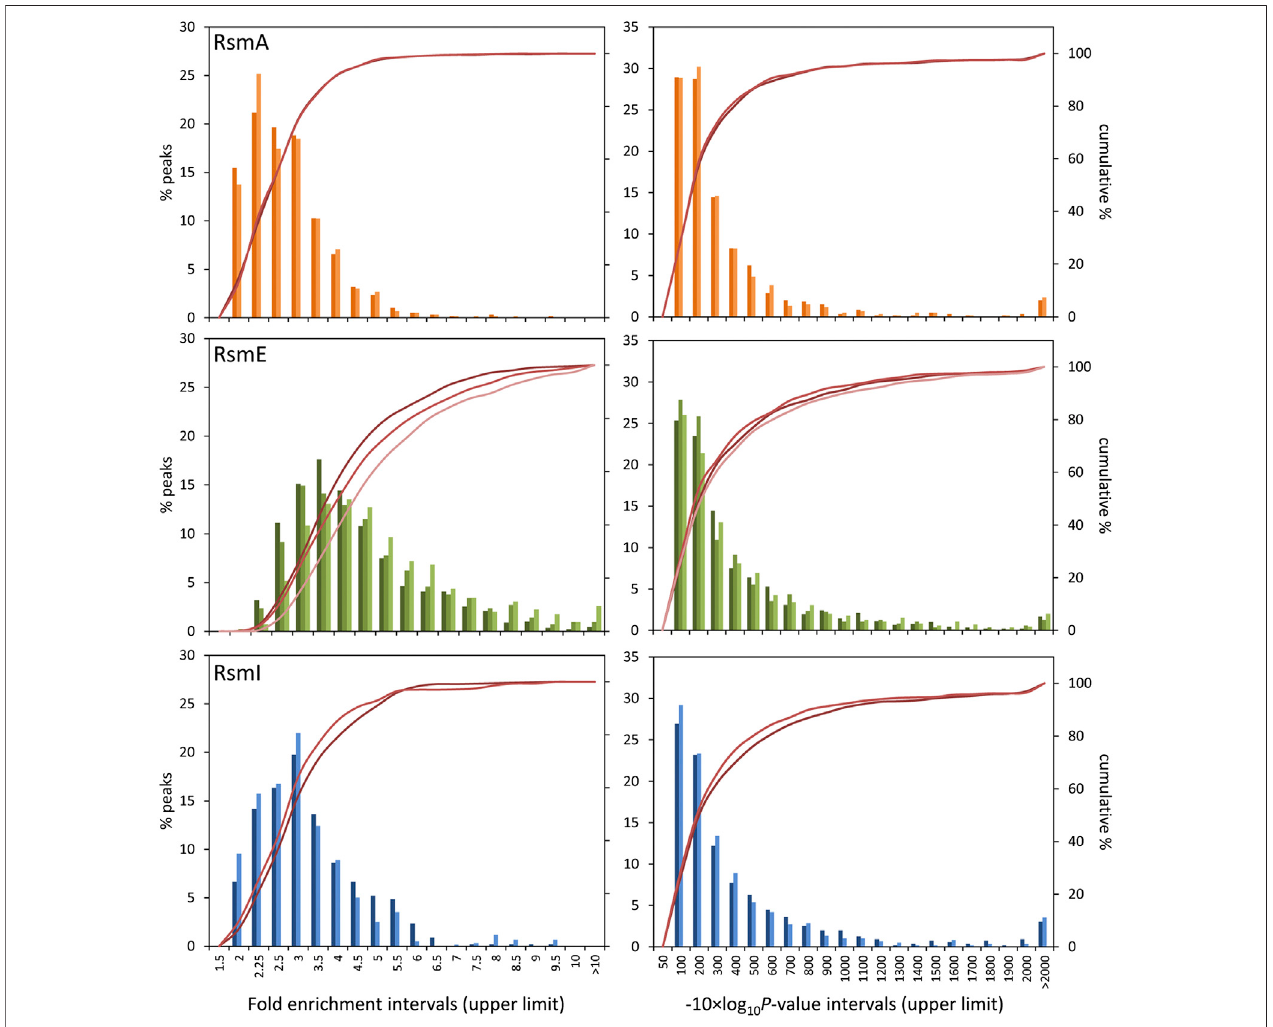
FIGURE1| Distributionoffoldenrichment (left) and − 10 × Log 10 ( p -value)scores (right) dataofoverrepresented RNAsequences associatedtoeach Rsmprotein (orange, RsmA; green, RsmE; blue, RsmI) with respect to total RNA. Data were grouped in the value intervals indicated in the X -axis, where the number corresponds to the upper limit of each interval. The histograms (primary Y -axis) show the frequency of targets in each interval. The crimson lines (secondary Y -axis) correspond to the cumulative percent values. The different color intensities in the histograms and lines correspond to the different biological replicates for each protein.